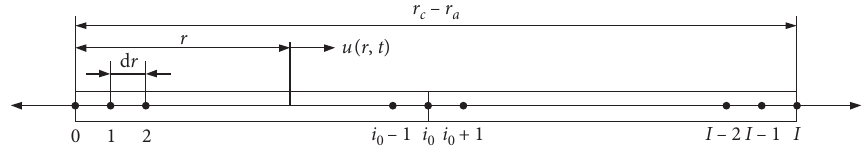
Figure 5: Discrete model of radial vibration of the